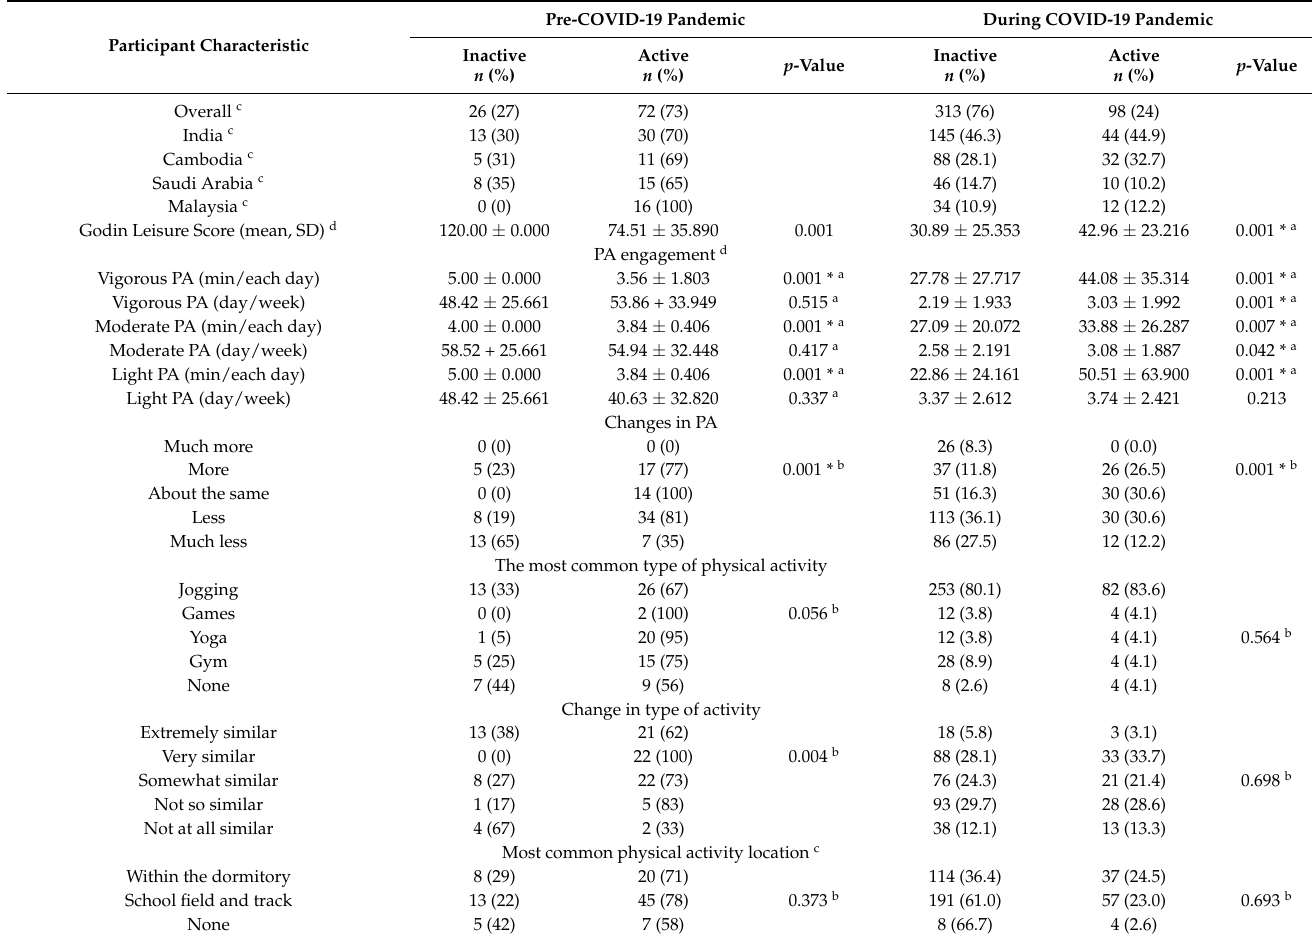
Table 2. Physical activity engagement, facilitators, barriers, and change in type of activities since